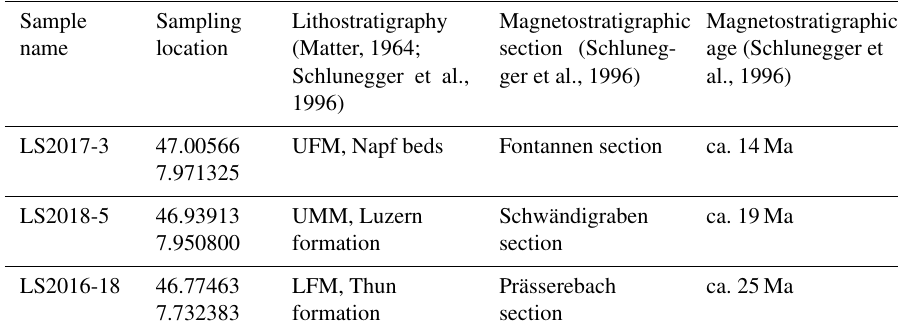
Table 1. Sample locations and characteristics of the Molasse sandstones from the Honegg–Napf fan. Abbreviations used: UFM – Upper Freshwater Molasse; UMM – Upper Marine Molasse; LFM – Lower Freshwater Molasse.